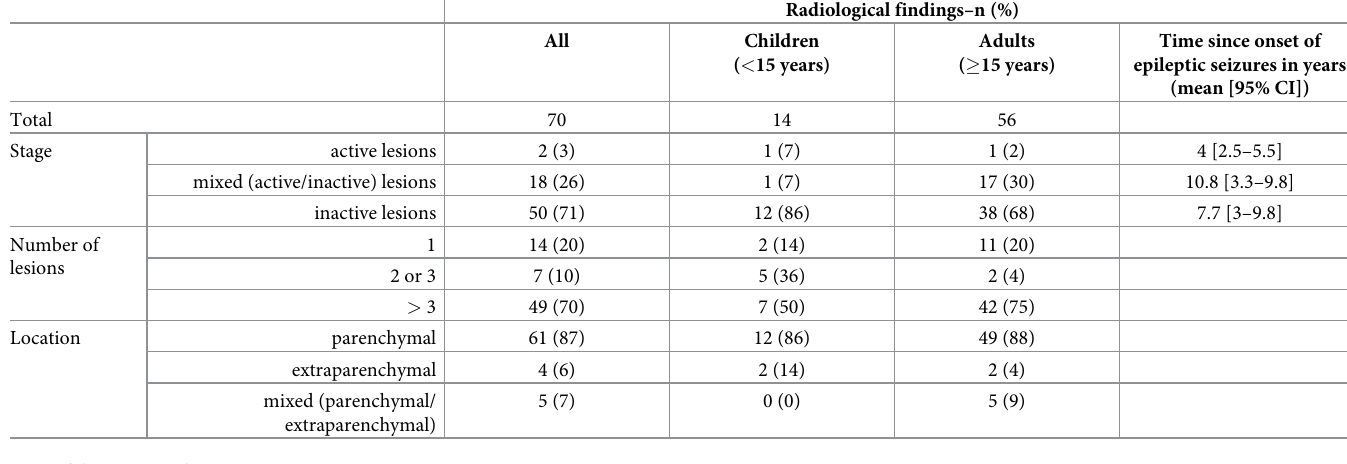
Table 2. Computed tomography findings in people with epilepsy and neurocysticercosis.